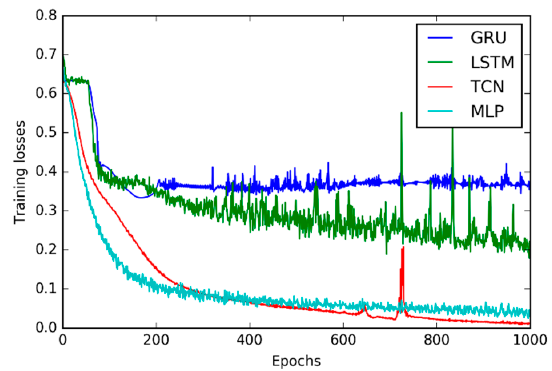
Figure 4. Training losses of the GRU, LSTM, TCN, and MLP.